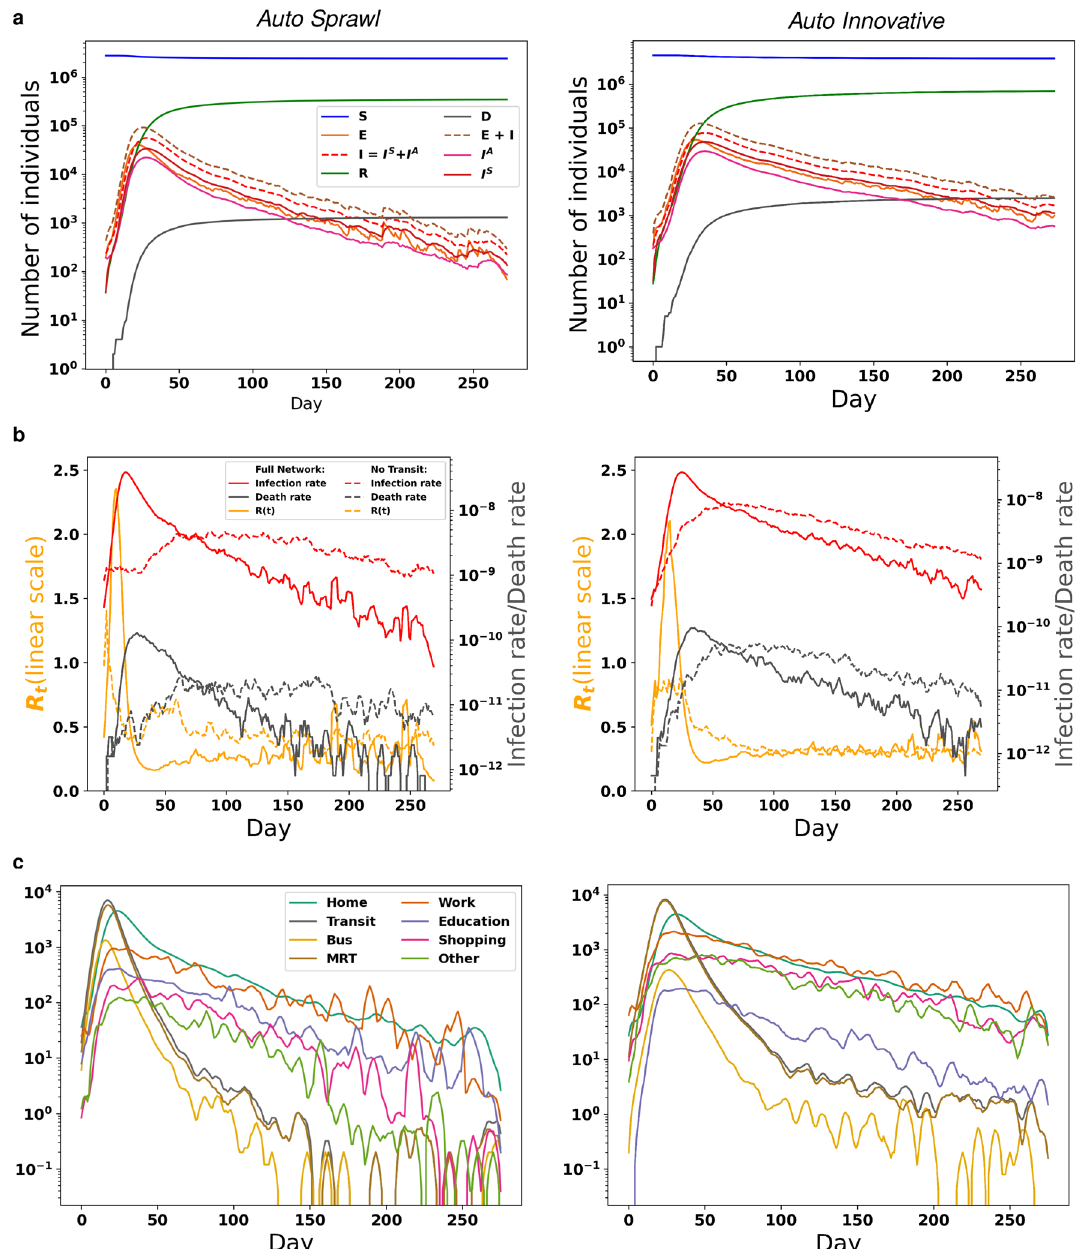
Figure 4. Simulated evolution of COVID-19 across two prototype cities. ( a ) Log y-axis of population states. ( b ) Time-dependent (daily) reproductive rate R t , infection and mortality rates. ( c ) Daily transmissions by activity. The curves are smoothed with a moving average over 5 days. The infection rate and death rate are expressed per 100,000